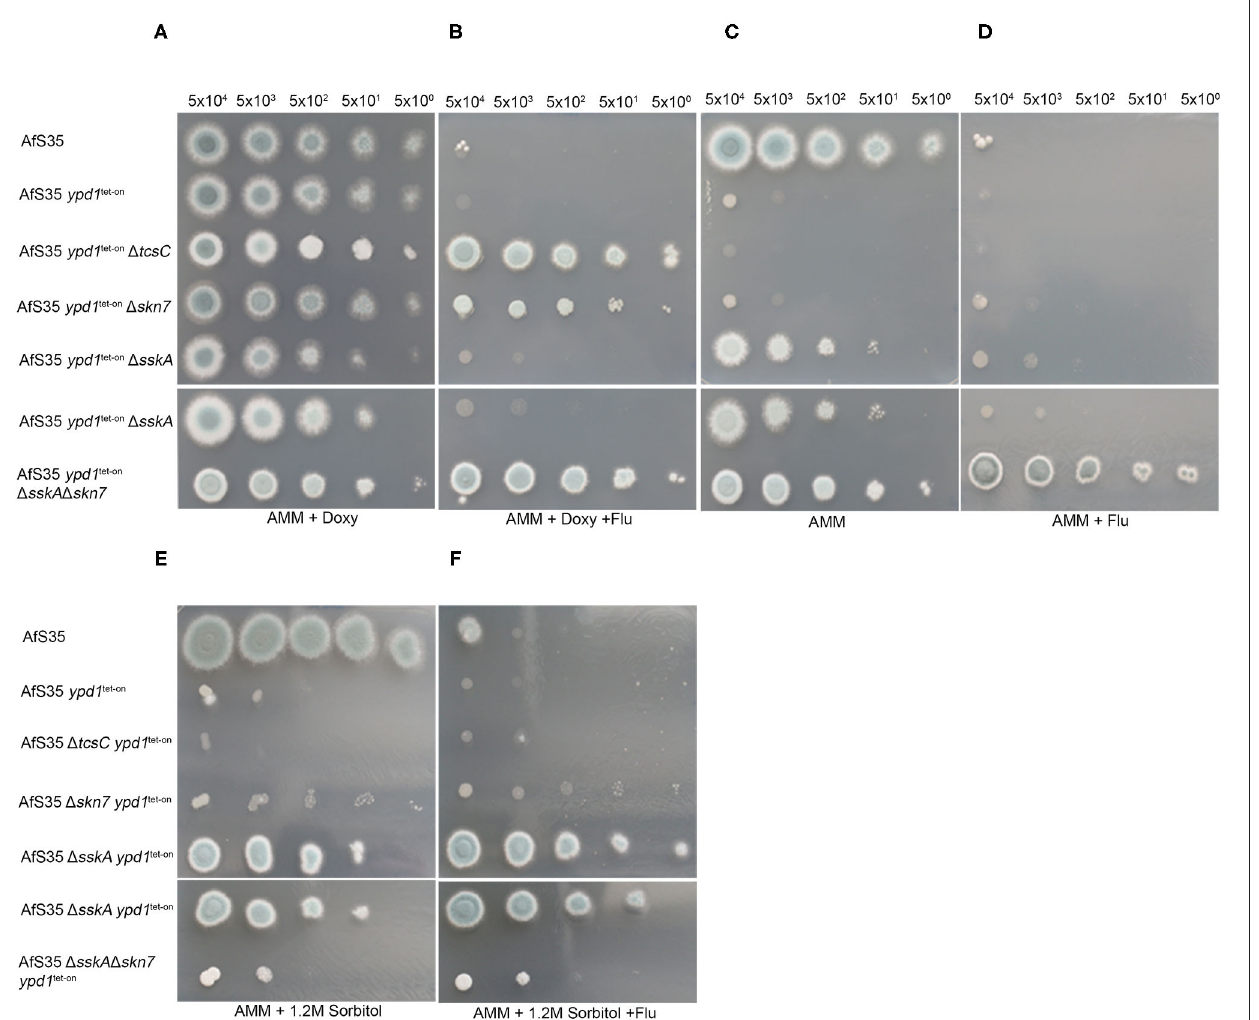
FIGURE 5 | Characterization of ypd 1 tet − on variants of different HOG mutants. We performed drop dilution assays with the indicated numbers of conidia per spot on AMM plates supplemented with doxy (5 µ g/ml), fludioxonil (1 µ g/ml) and sorbitol (1.2M) as indicated. All strains grew well on AMM + doxy (A) . Only strains lacking either ssk A or skn7 A were able to grow in the absence of doxy (C) . (B) Shows that only the ypd 1 tet − on variants of 1 tcs C, 1 skn 7 and 1 ssk A 1 skn 7 are resistant to fludioxonil, when grown in the presence of doxy. Under non-inducing conditions, the 1 ssk A ypd 1 tet − on is sensitive to fludioxonil, whereas the 1 ssk A 1 skn 7 ypd 1 tet −